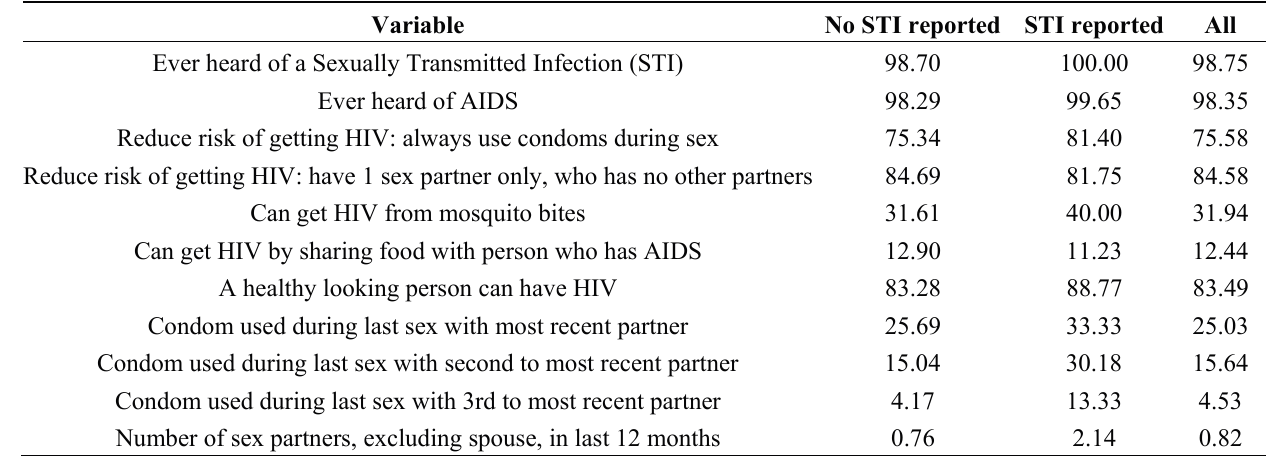
Table 3. Knowledge of STIs among the men and use of